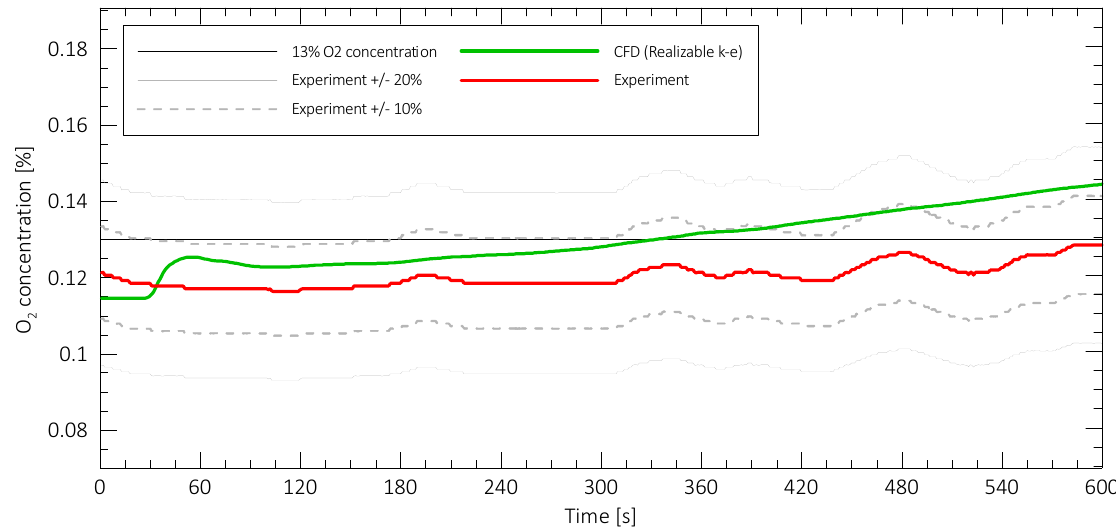
Figure 15. Changes in oxygen concentration (v/v) on the probe No. 1, indicating the end of the retention time during experimental tests and CFD simulations, fire-extinguishing gas Ar 10% v/v and N 2 90% v/v.